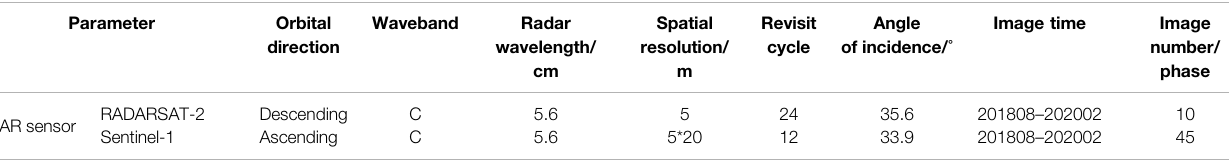
TABLE 2 | Basic parameters of the satellite-based SAR